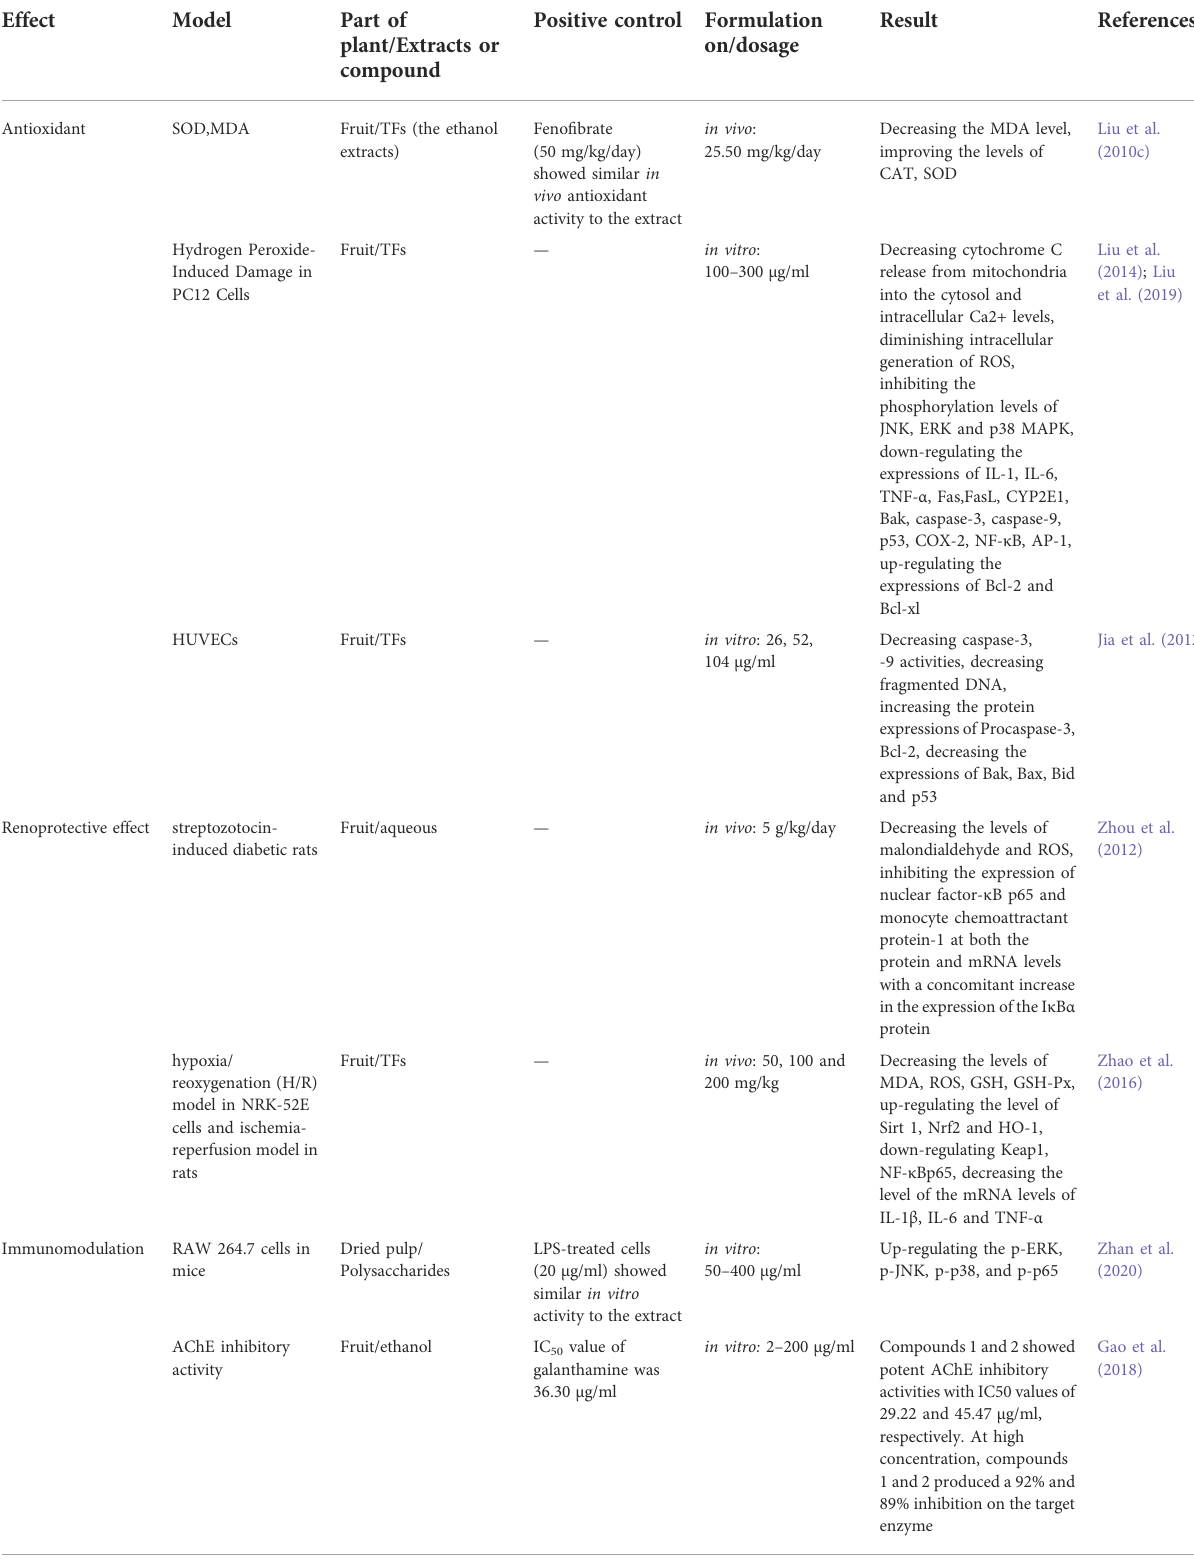
TABLE 2 Modern Pharmacological studies of R. laevigata